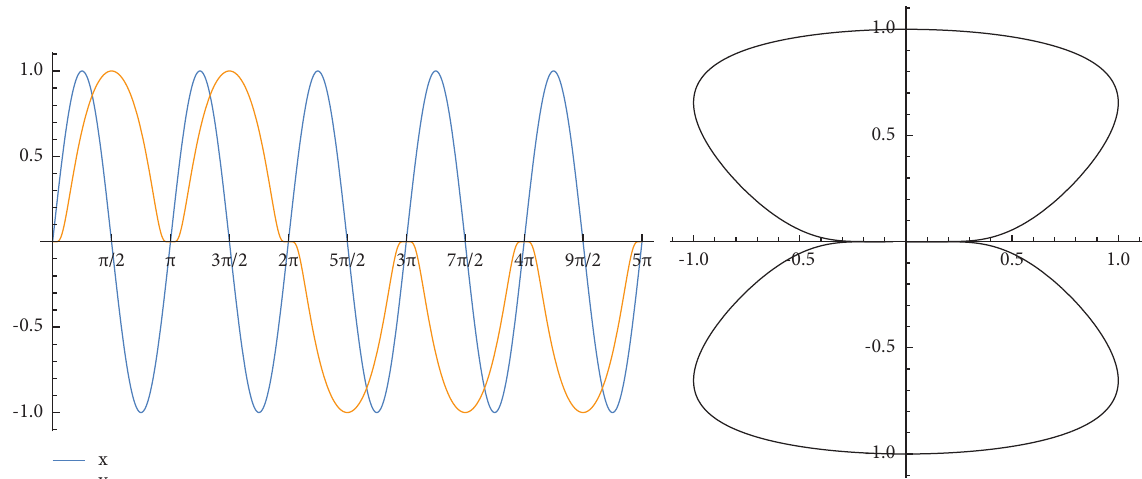
as defined in (18); graph of η 0